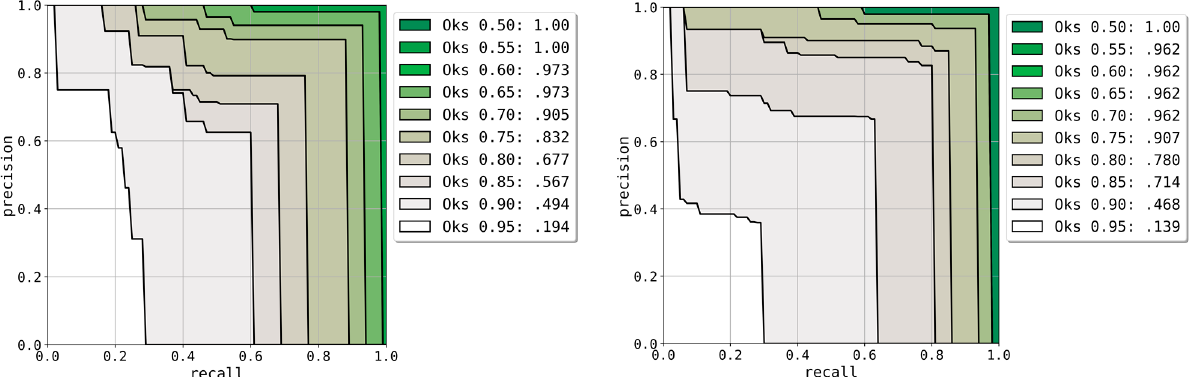
Figure 4. Precision–Recall graph for various object keypoint similarity (OKS) thresholds. Each colored graph represents each OKS threshold, and each point in the graph corresponds to a specific confidence score threshold of the model. Left: result of the upper images. Right: result of the lower images.